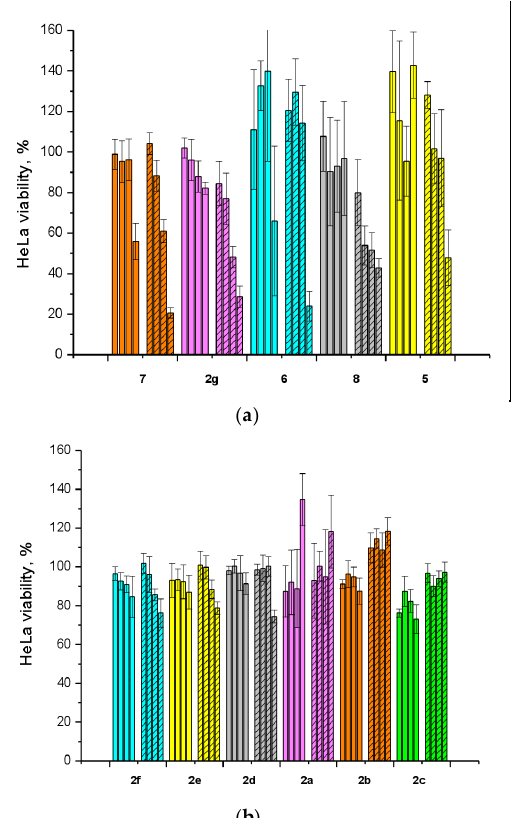
Figure 2. Dose-dependent action of the lipophilic nucleosides in combination with topotecan (Tpc) on HeLa cell viability in the EZ4U assay. The unshaded histogram bars denote cell viability in the presence of a single Tdp1 inhibitor. The hatched histogram bars indicate cell viability in the presence of a combination of a Tdp1 inhibitor with 2 μM topotecan. ( a ) Compounds showing synergy with topotecan. The colors indicate: orange–compound 7 , magenta— 2g , cyan— 6 , gray— 8 , and yellow— 5 . ( b ) Inactive compounds. The colors indicate: cyan—compound 2f , yellow— 2e , gray— 2d , magenta— 2a , orange— 2b , and green— 2c . Each of the four bars corresponds to an inhibitor concentration (from left to right) of 1, 5, 20, and 100 µ